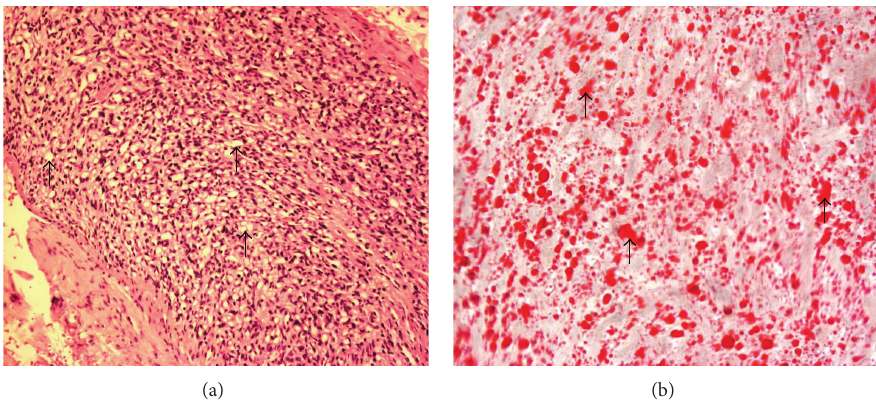
Figure 6: 100x magnification of the H & E section (a) showing numerous fine capillaries (dark purple dots) separated by stromal cells with vacuolated cytoplasm (nonstained areas, black arrows). Oil Red O stain ( × 400 magnification; (b)) demonstrates tumour cells that are lipid laden (all regions stained red, illustrated with arrows). Overall features are compatible with a haemangioblastoma.